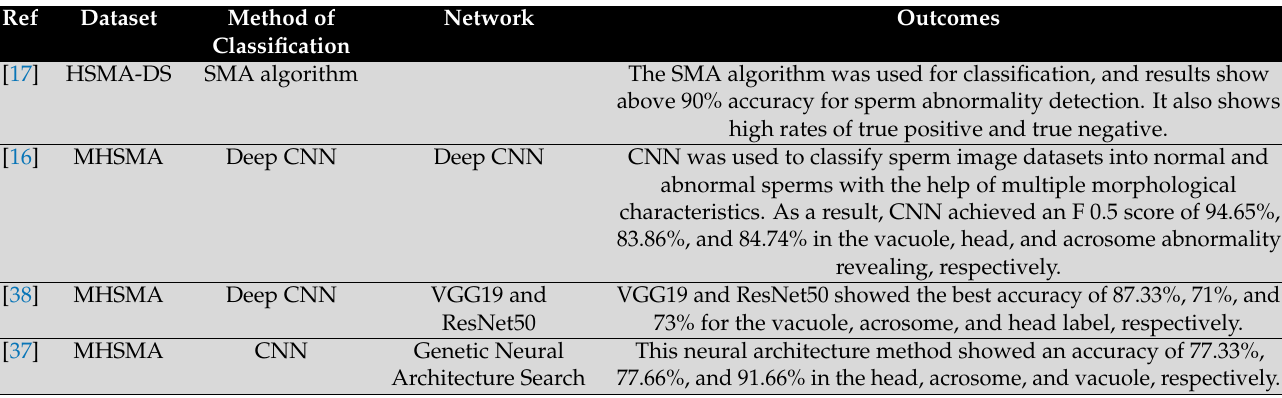
Table 1. MHSMA dataset with previously proposed